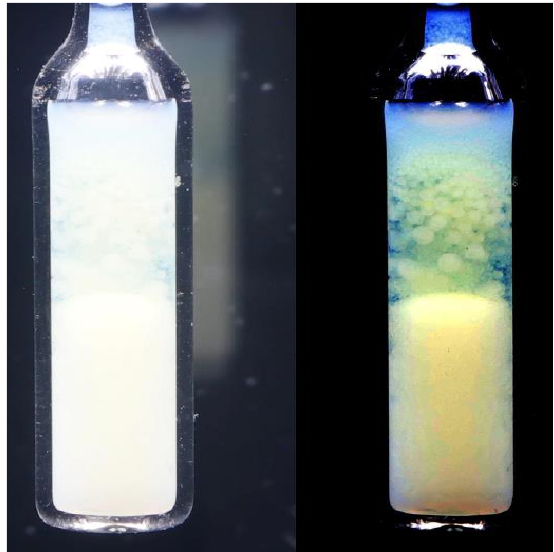
Figure 13. Photos showing two coexisting phases (isotropic liquid and nematic phase) in MBBA + isooctane mixture for TP1 domain related to low concentrations of isooctane. The photo is for 𝑥 = 0.1 𝑚.𝑓. and the quench temperature 𝑇 = 𝑇 2𝑃𝐼 − 1𝐾 . The left part is for the ‘native’ photo, and the right part is after the numerical filtering, reducing the impact of the opalescence and allowing insight into the sample interior.